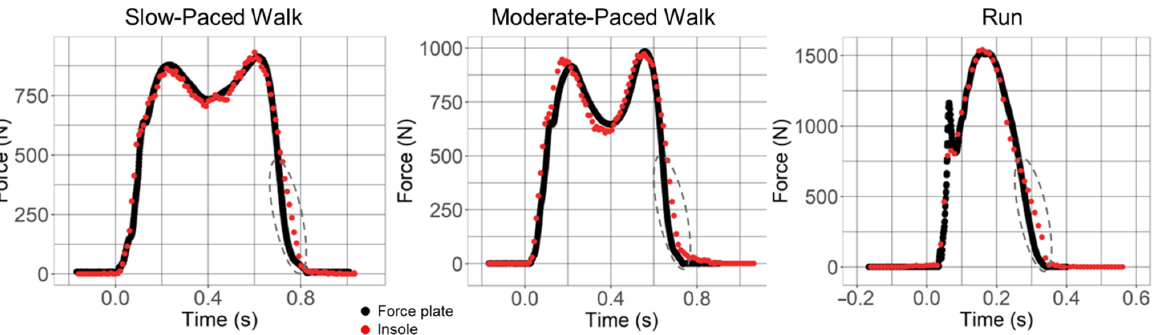
Figure 3. Representative vertical ground reaction force (vGRF) time plots from force plate (black) and Insole3 data (red) versus time. Both walks demonstrate characteristic double-peaked curves with two maxima (Peak 1 and Peak 2), and one minimum (valley), and the jogging trial represents a typical single-peaked curve with the presence of an impact transient prior to the peak. Target speed ranges were 1.2–1.4 m/s for the moderate-paced walk, 0.8–1.0 m/s for the slow walk, and 3.3–3.7 m/s for the jog. Gray dashed ellipses indicate regions that demonstrate a slight lag in the vGRF at the end of the stance phase with the insole.